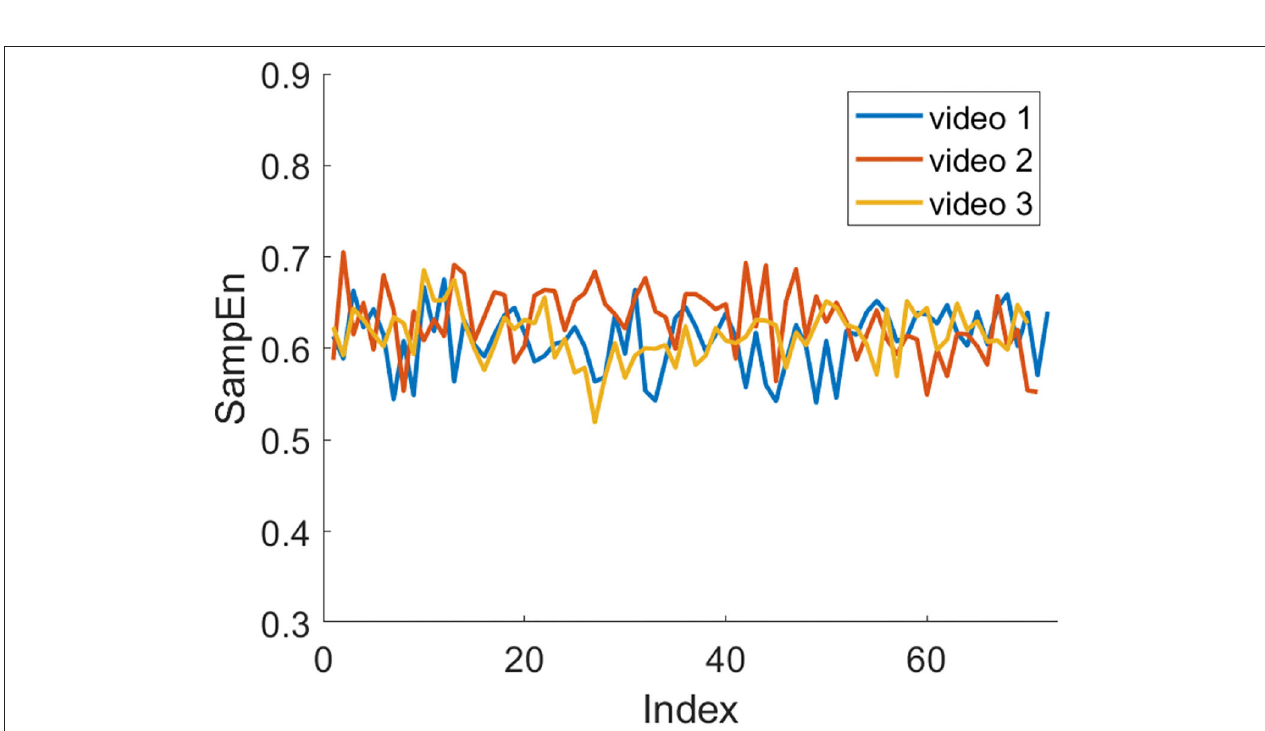
FIGURE 10 | Average SampEn of three videos in session 2 over